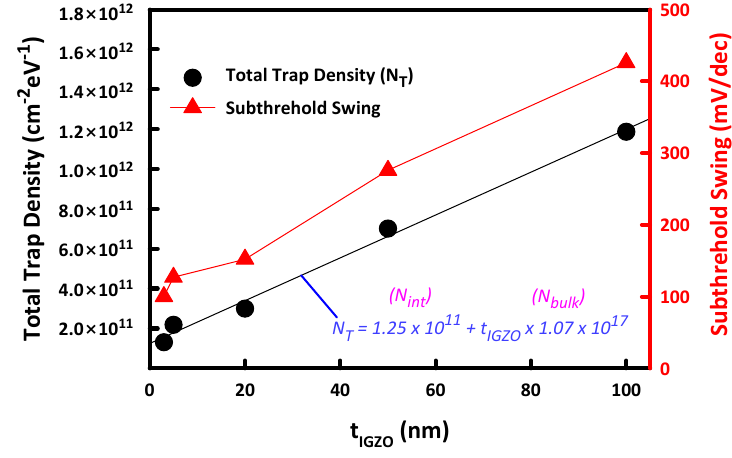
Figure 7. Amorphous indium-gallium zinc-oxide (a-IGZO) semiconductor thickness ( t IGZO ) dependency of total trap density ( N T = N int + t IGZO × N bulk ), where N int is the area density of the shallow traps close to the Fermi level ( E F ) at the gate-insulator/semiconductor interface and N bulk is the volume density of shallow traps in the bulk of the a-IGZO semiconductor.